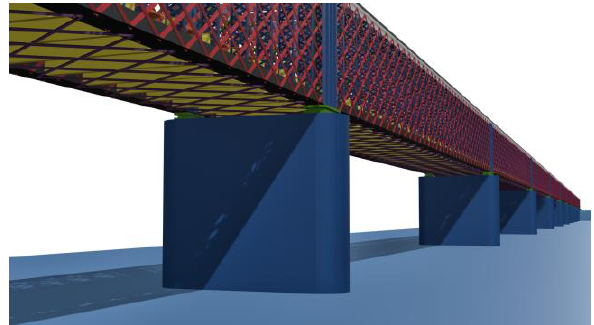
Figure 12 . Bottom view of the bridge in Mezzana